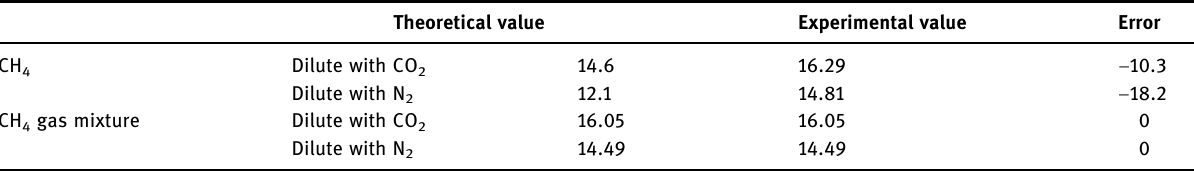
Table 3: Comparison of experimental and theoretical critical oxygen